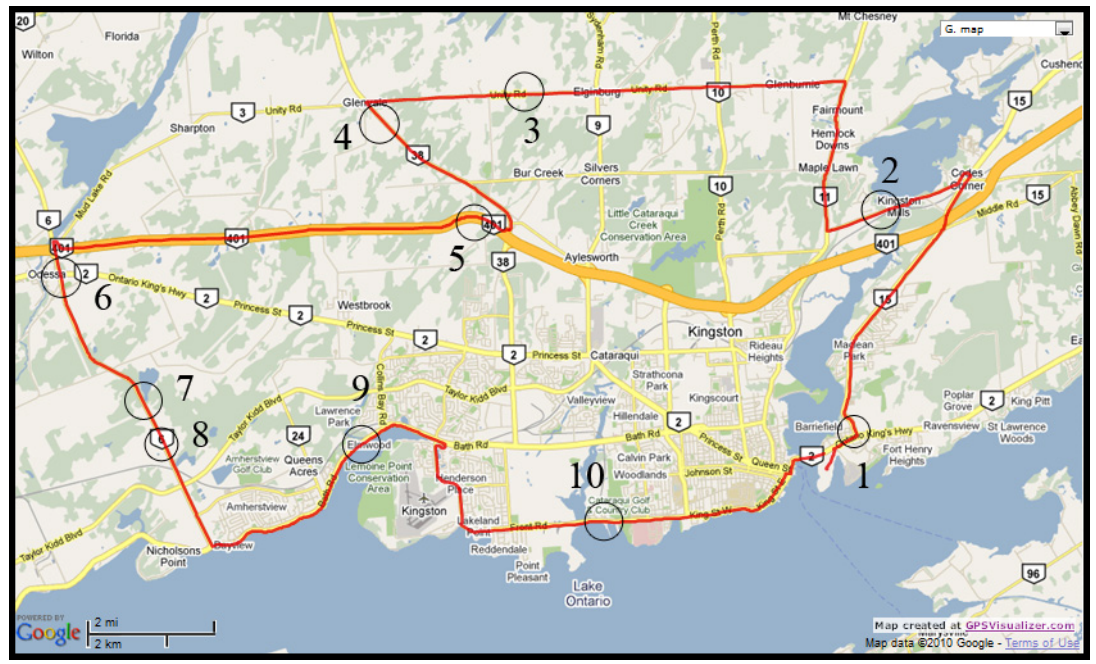
Figure 2. Road test trajectory around the Kingston area. Circles indicate the locations of GPS outages.